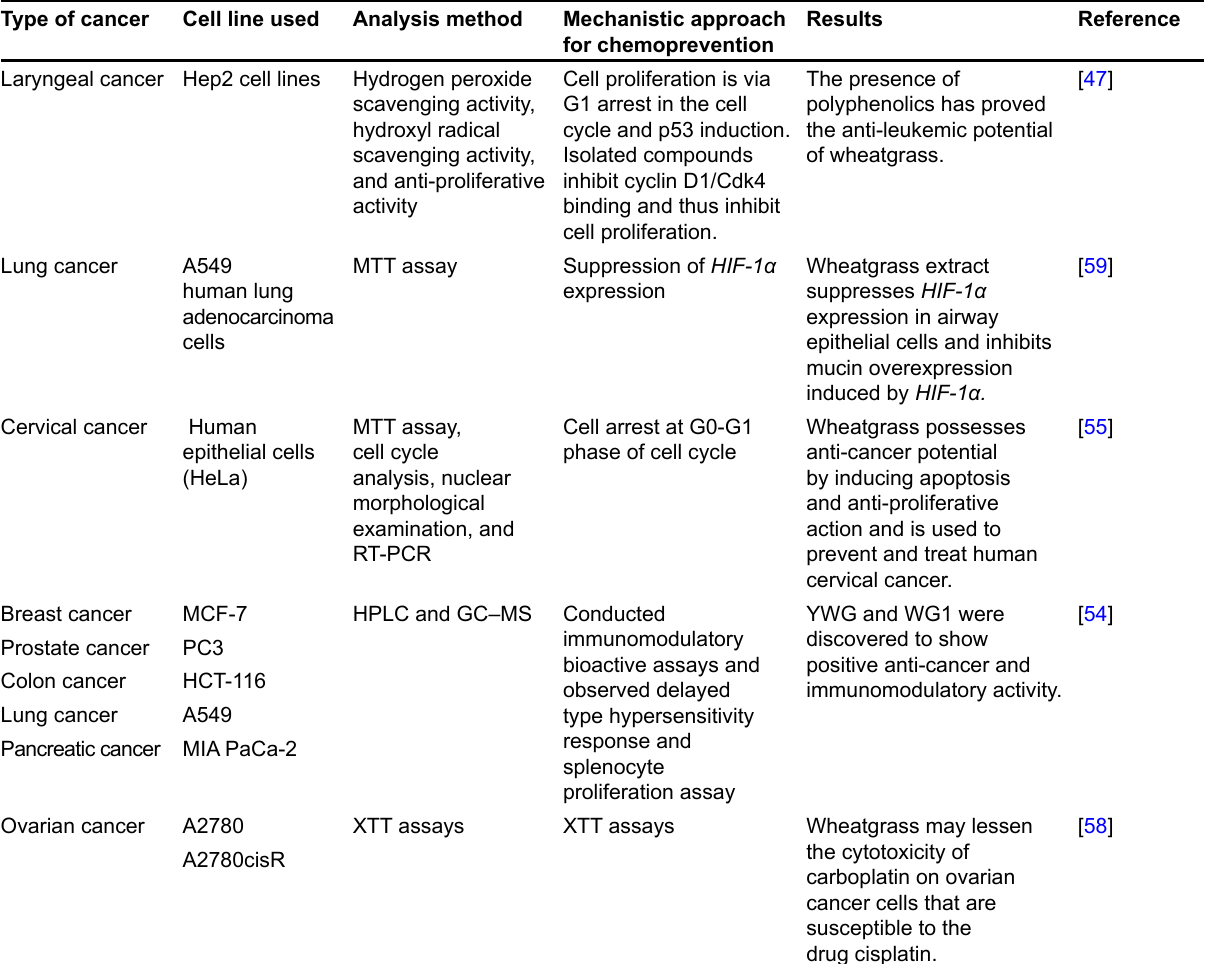
Table 3. Studies on wheatgrass ameliorating